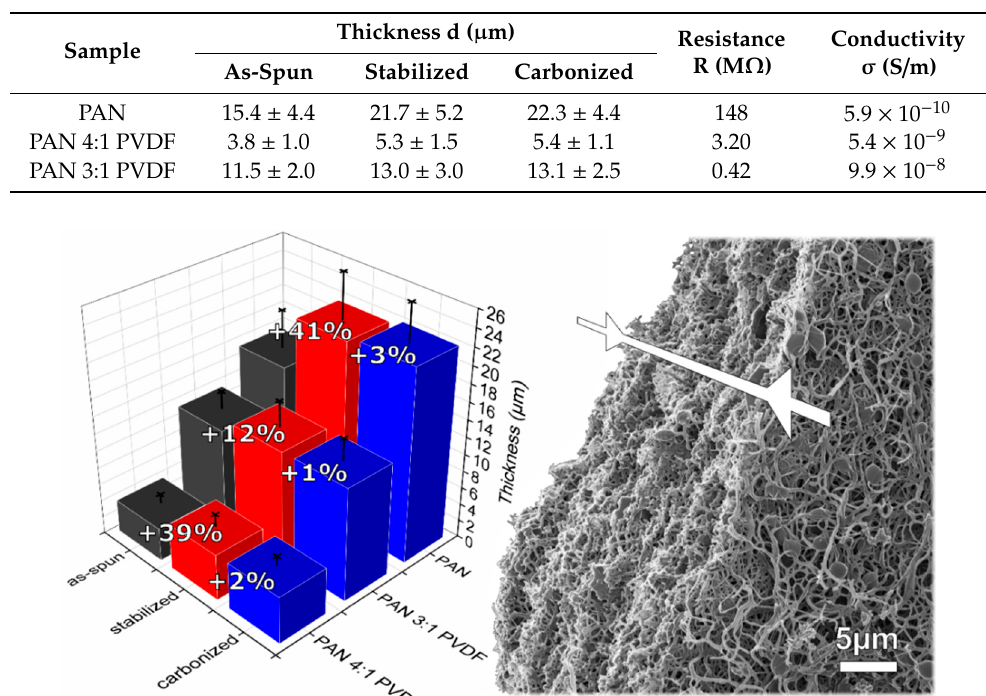
Figure 3. Results of thickness measurements by the amplitude-sensitive eddy current method of all examined nonwovens with respective percentage changes from one process step to the next and HIM image of a carbonized PAN nonwoven edge as seen from diagonally above. Exact thickness values are given in Table 1.